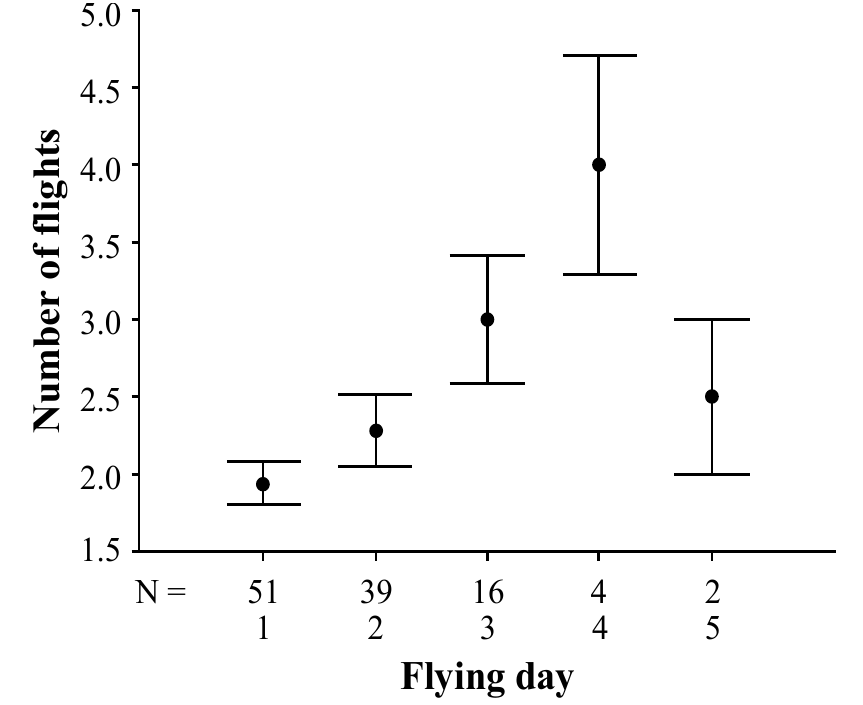
Figure 4. Comparison of the daily number of nuptial flights between different consecutive flying days. Arithmetic mean and standard error are given for each day. N is the number of queens flying on one to five consecutive